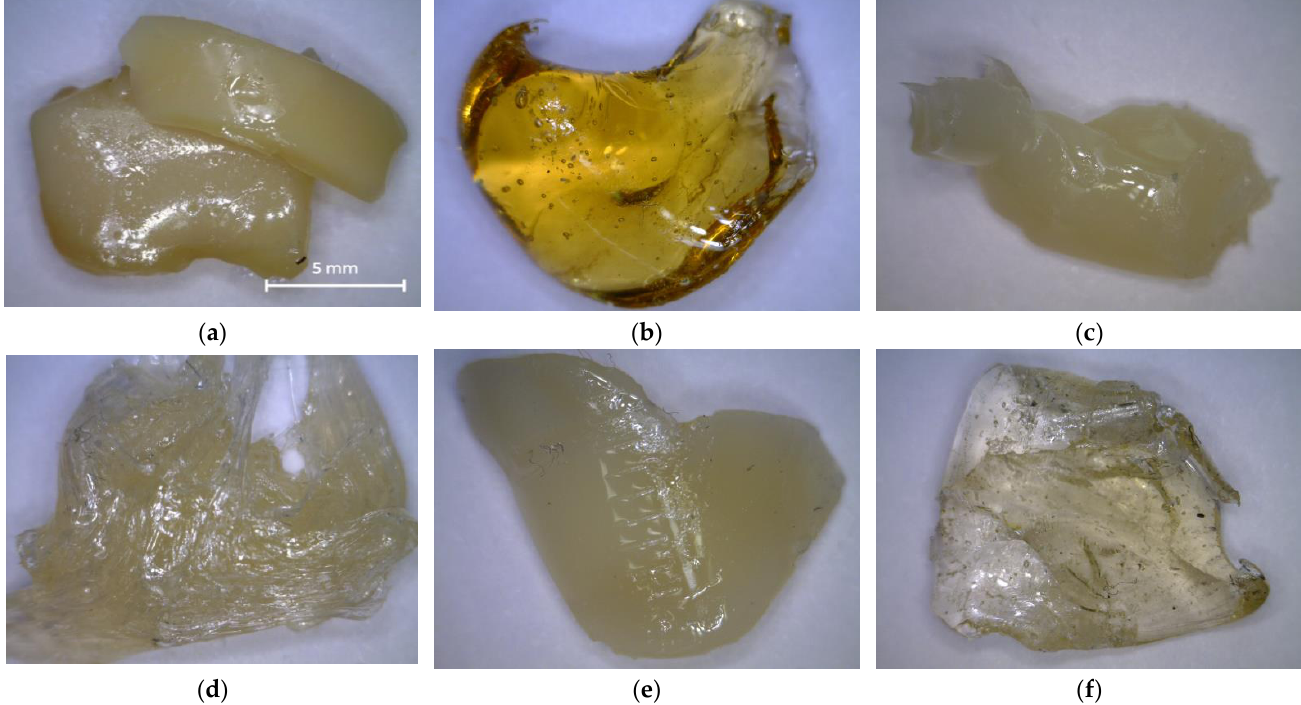
Figure 9. Photos of UPR samples: ( a ) UPR-1; ( b ) UPR-2; ( c ) UPR-3; ( d ) UPR-4; ( e ) UPR-5; ( f ) UPR-6. IR spectra of UPRs are shown in Figure 10. The spectra of all samples show an ele- vated region of 2300–3700 cm −1 , which corresponds to the hydroxyl end groups. The IR spectra of UPR-2, UPR-4, and UPR-6 resins show a band at 1780 cm −1 (anhydride, stretch- ing) corresponding to maleic anhydride.